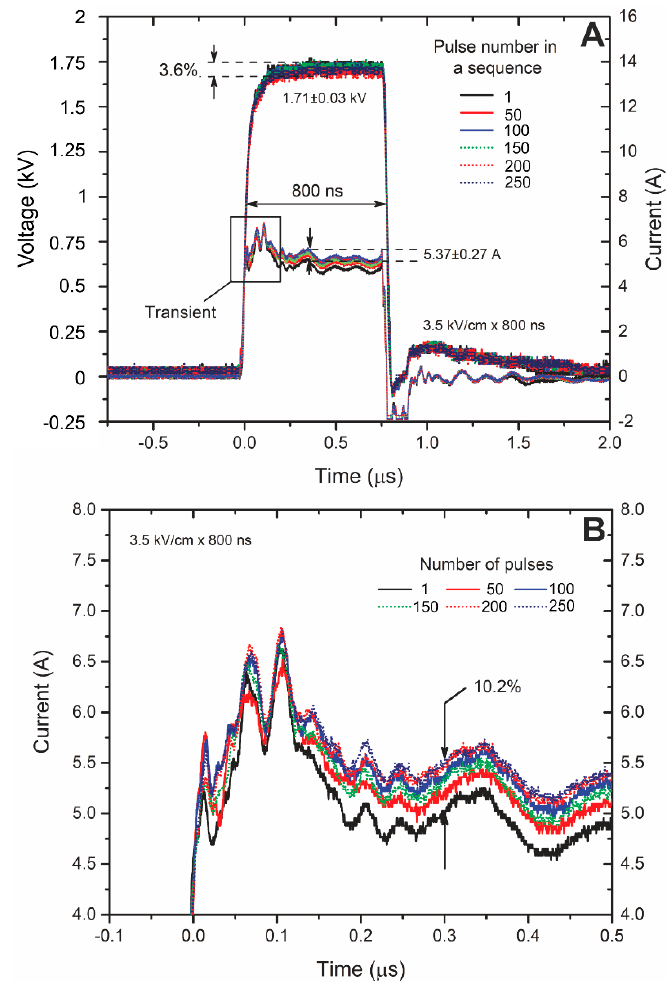
Figure 7. The current and voltage waveforms ( A ) during the nanosecond range electroporation and the magnification ( B ) of the current pulses for better informativity.